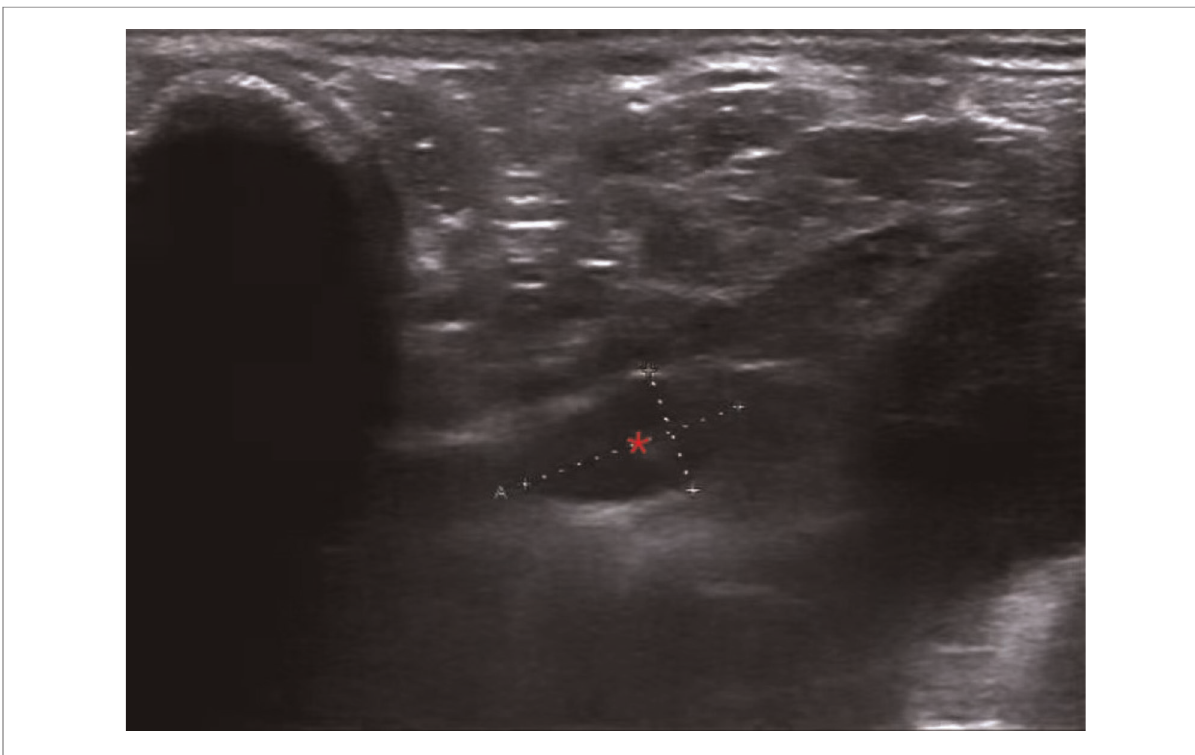
FIGURE 1 Parathyroid ultrasound showing a hypoechoic nodule (*) on the left side of the suprasternal